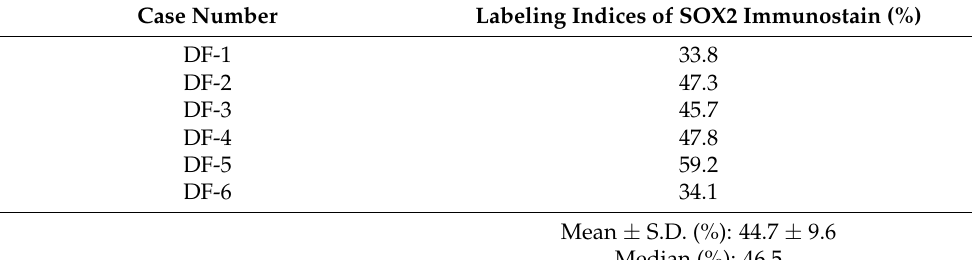
Table 2. Expression status of SOX2 in remnants of odontogenic epithelial